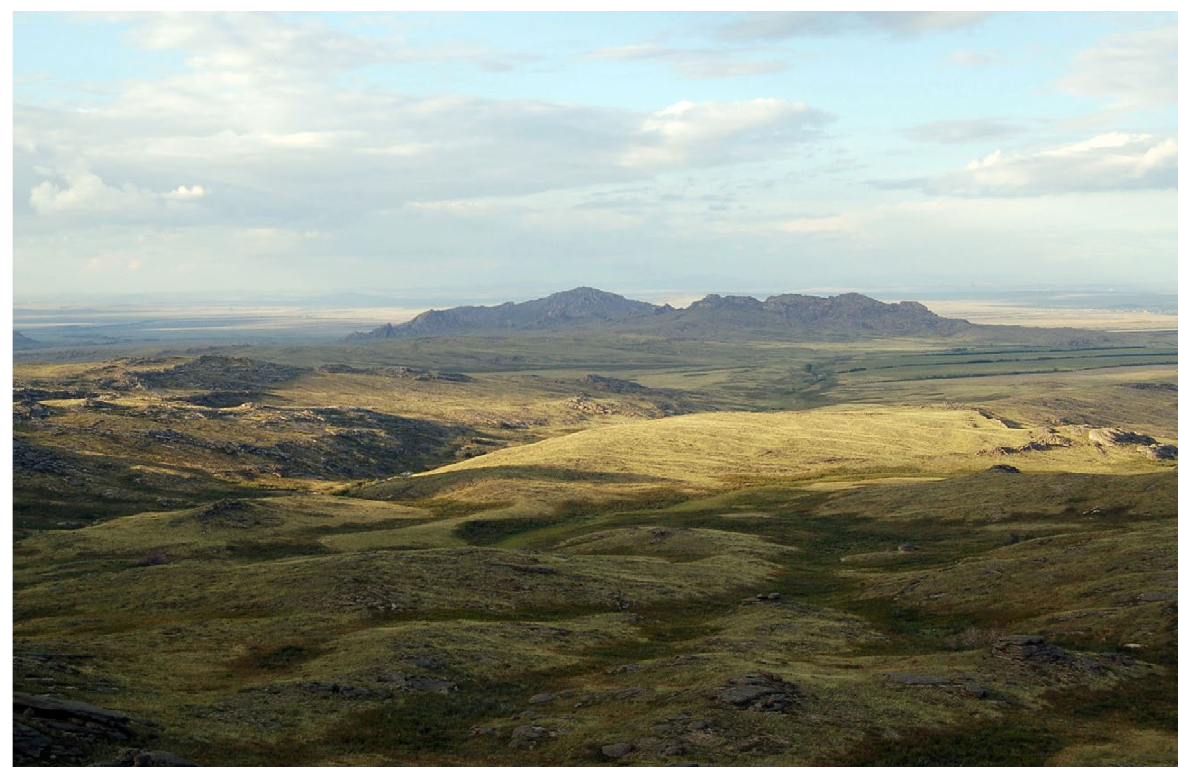
Fig. 7. A geomorphically very diverse semi-arid open steppe landscape of the Sary-Arka (the eastern part of the Central Kazakhstan Highlands – Mel’kosopochnik) with rocky hills and deep ravines formed by exposed Pre- Cambrian granitic